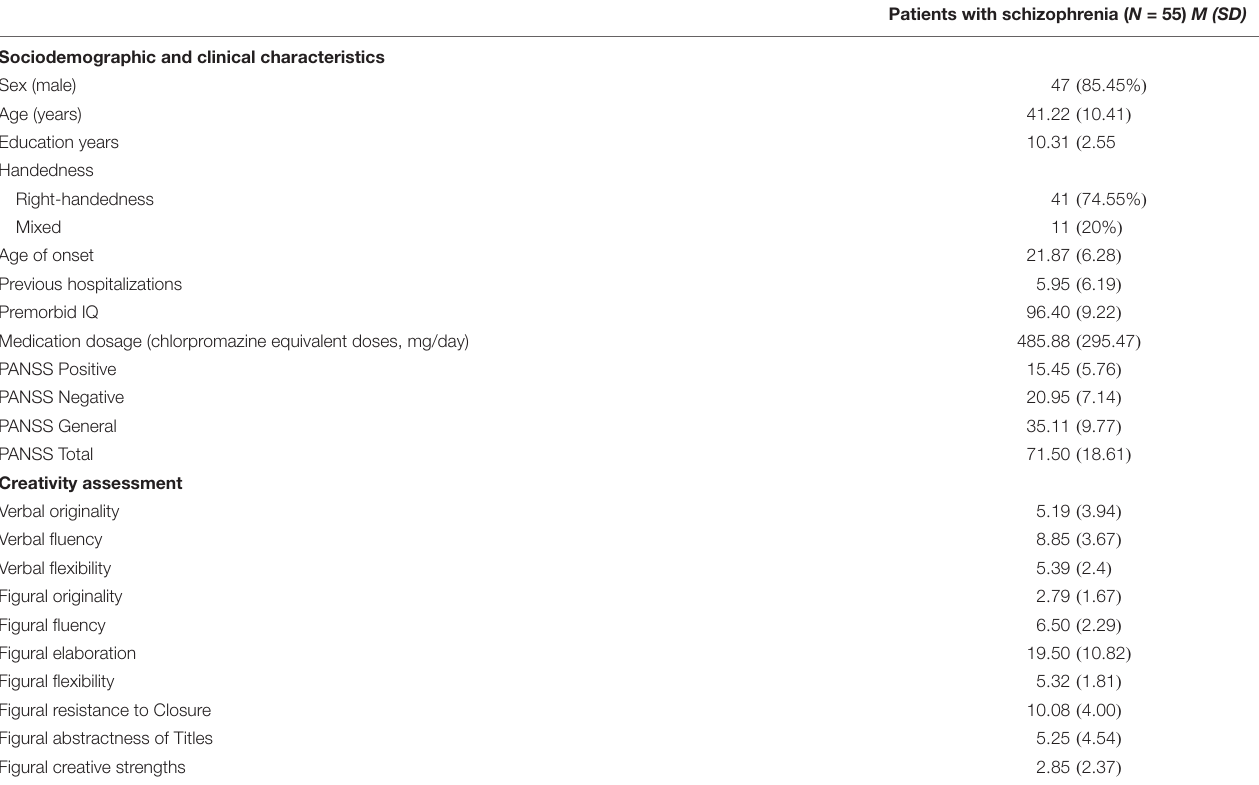
TABLE 1 | Sociodemographic, clinical, and creativity data of the sample.